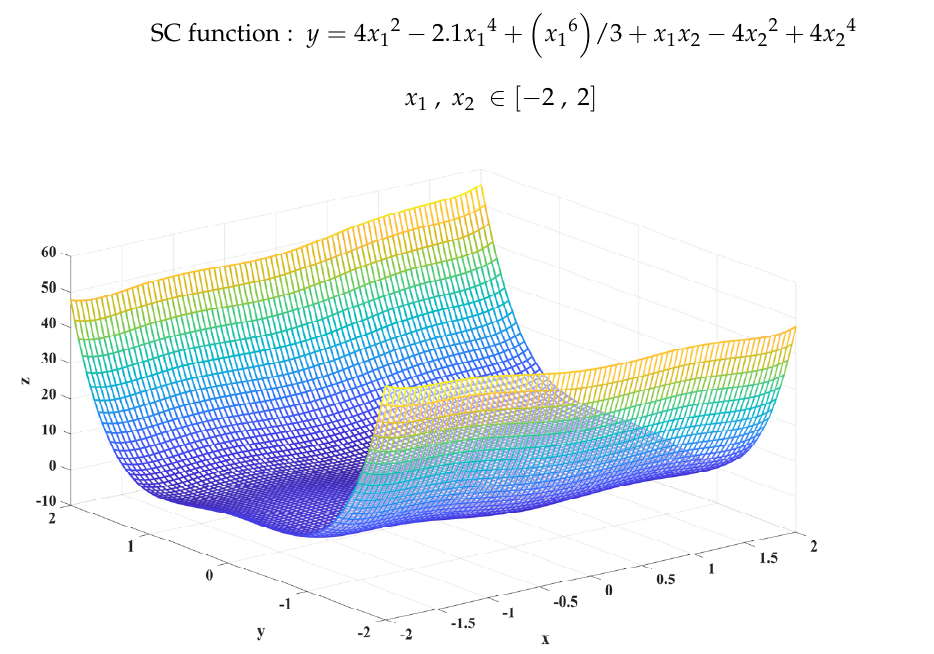
Figure 3. Plot of the SC function.